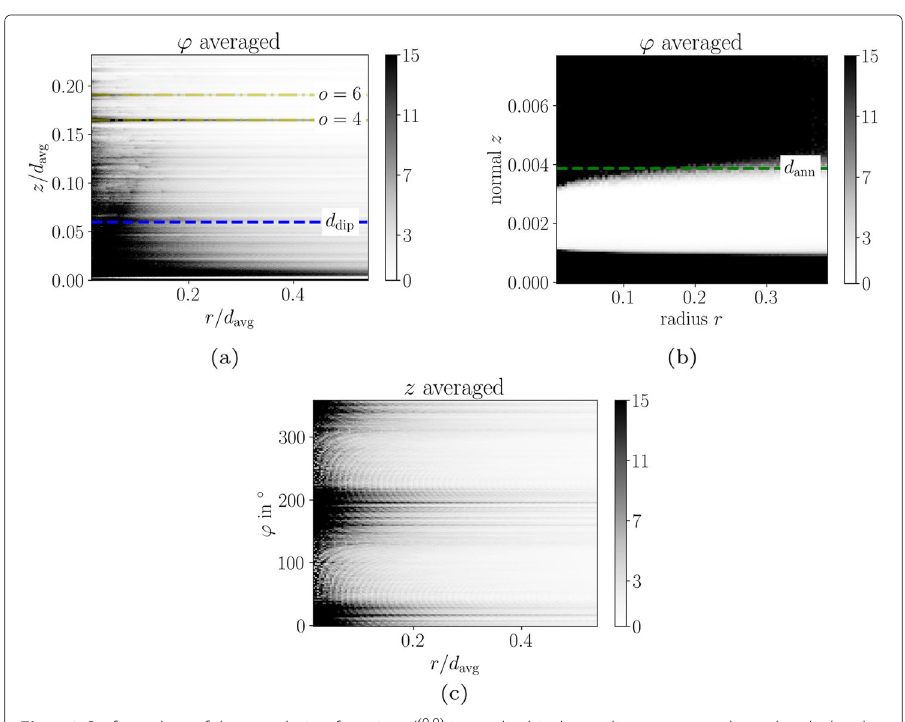
Fig. 16 Surface plots of the correlation function d ( 0,0 ) in a cylindrical coordinate system aligned with the slip plane. The values for r and z are given in multiples of the average dislocation spacing d avg = 1 √ ρ . Averaged over angular domain ( a ). The dashed line is the average dipole height (cf. Eq. (109)), the dash-dotted lines indicate planes re-entering the domain due to periodicity of order o , and therefore contain self-correlation. Gap in the correlation in normal direction (zoomed in z-direction of ( a ) using a finer spatial resolution) ( b